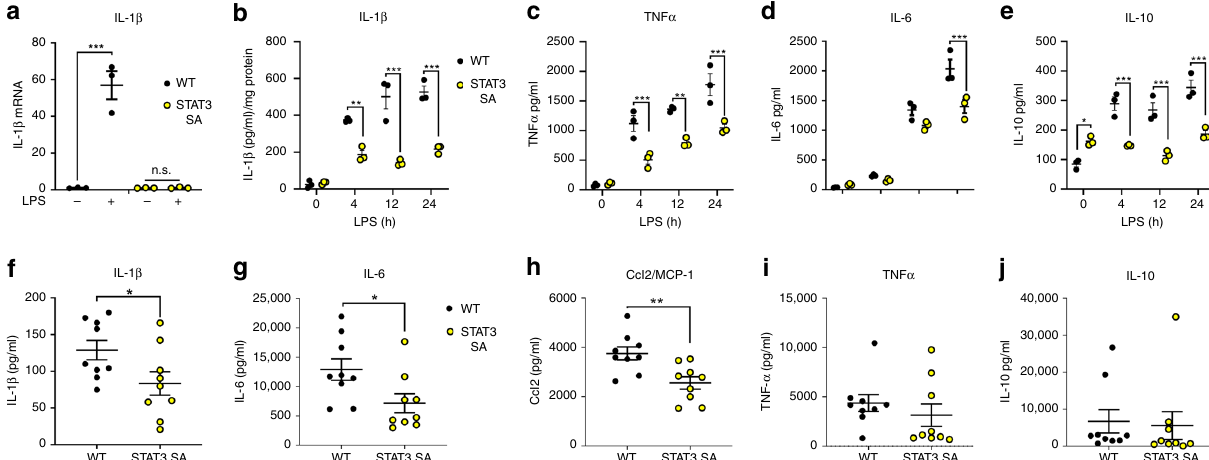
Fig. 5 STAT3 pS727 is required for LPS-induced cytokine expression. a Peritoneal macrophages obtained from three mice per genotype were seeded at 5 × 10 5 cells/well in and stimulated with LPS (100 ng/ml) for 24 h prior to analysis IL-1 β mRNA expression. Data are presented as mean values ± SEM, *** p < 0.0001, n.s. — not signi fi cant, one-way ANOVA, Tukey ’ s multiple comparisons test. Peritoneal macrophages generated from individual WT